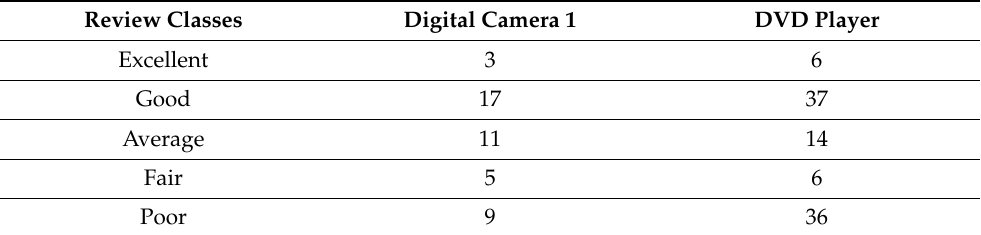
Table 4. Review quality evaluation of Digital Camera 1 and DVD Player.